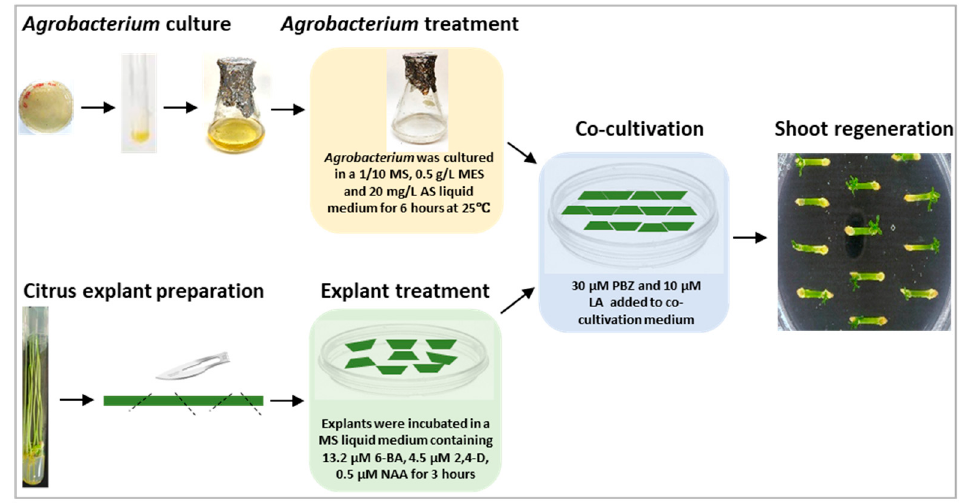
Figure 5. An outline of an improved procedure for Agrobacterium -mediated citrus transformation. Three simple treatments described in colored boxes were added to a conventional procedure for Agrobacterium -mediated citrus transformation, and these treatments significantly enhanced genetic transformation efficiency for ‘Carrizo’ citrange. AS: acetosyringone, MES: 2-( N -morpholino) ethanesulfonic acid, PBZ: paclobutrazol and LA: lipoic acid.